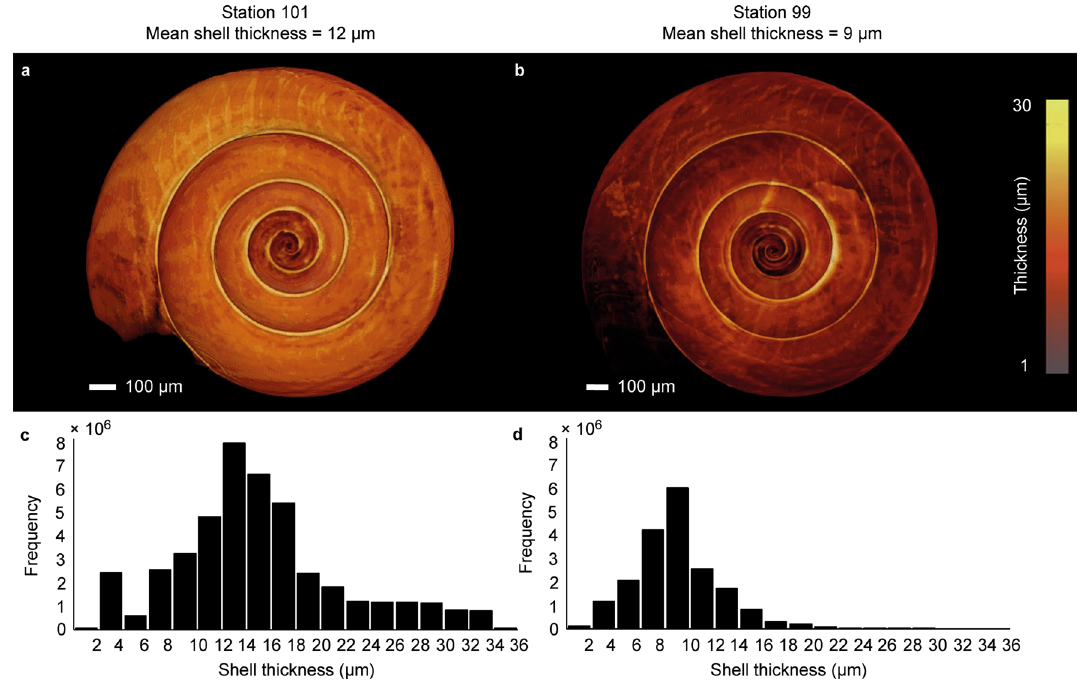
Figure 3. Variation in shell thickness measured by micro-CT scans of two Limacina helicina specimens. ( a ) A thick shell sampled offshore (station 101). ( b ) A thin shell sampled onshore (station 99). Coloring indicates shell thickness, with brighter colors for thicker areas. ( c , d ) Frequency distribution of shell thickness of the two specimens. These frequency distributions were used to calculate average thickness per